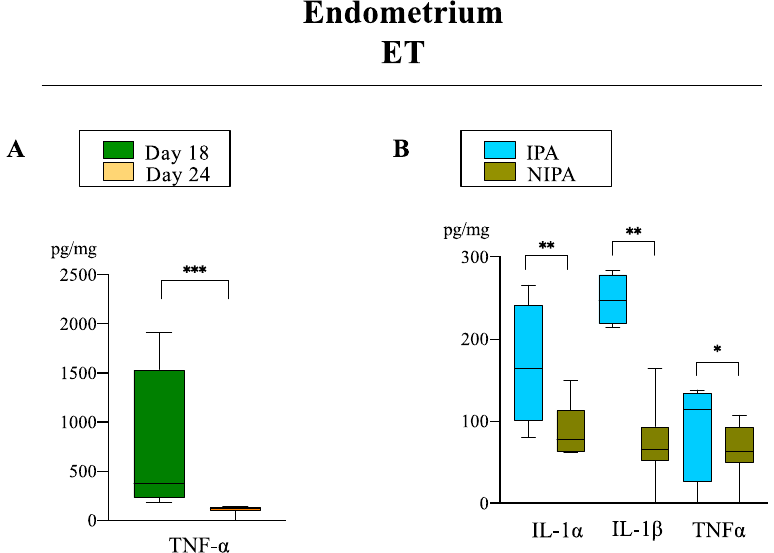
Figure 4. Relative abundance of pro-inflammatory cytokines (pg/mg of total protein) in ET group between days ( A ) and endometrial areas ( B ). Data are presented by box plot showing median and interquartile range (Q1–Q3). Asterisks indicate significant differences among groups (* p < 0.05; ** p < 0.01; *** p < 0.001).